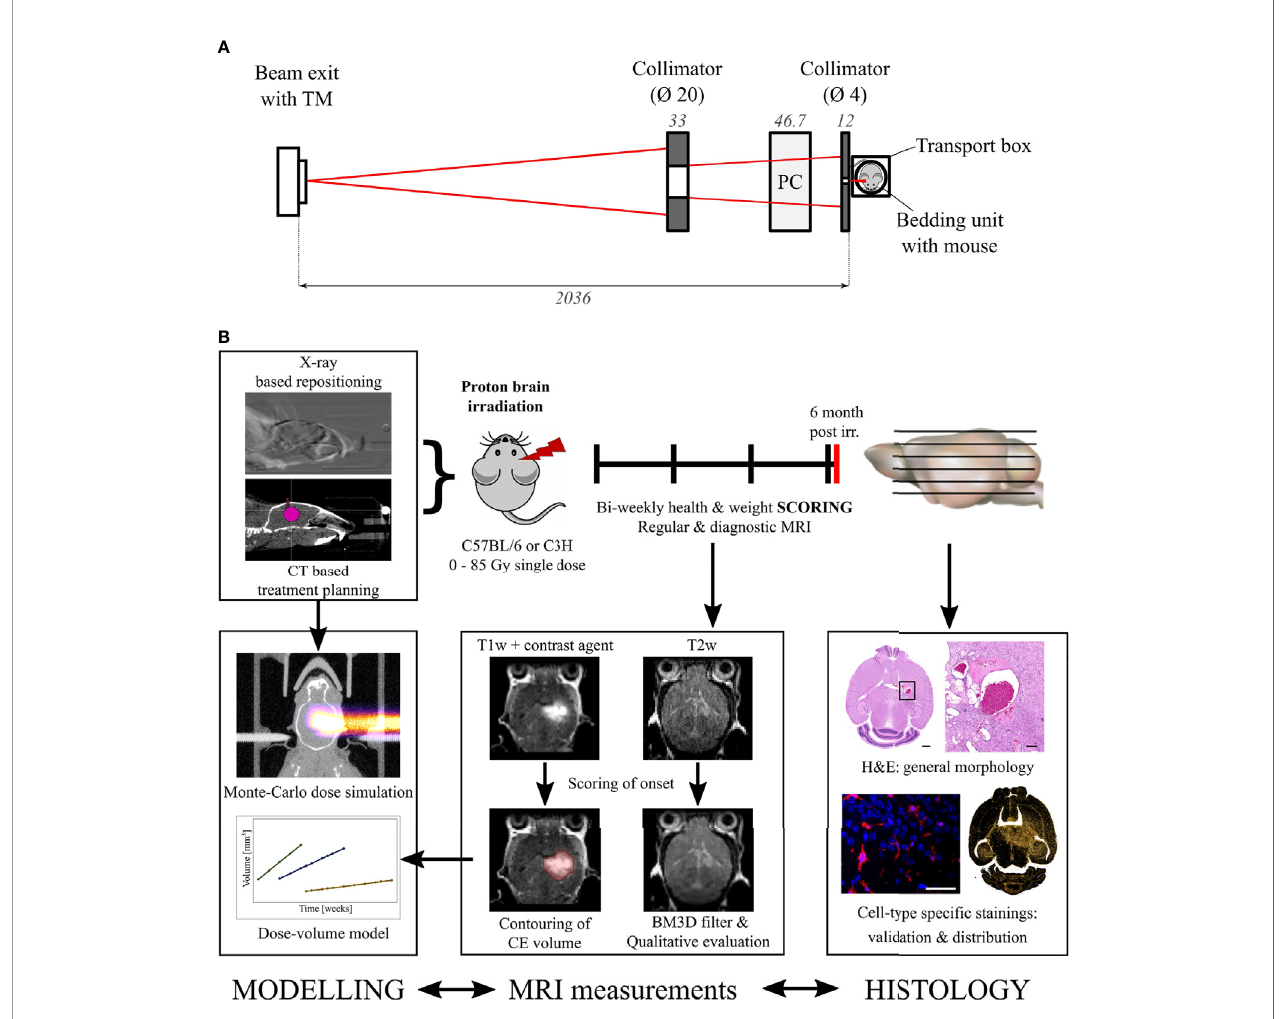
FIGURE 1 | Irradiation setup and experimental procedure. (A) Schematic representation of the beam shaping system. Left to right: A 90 MeV proton beam (red) exits the vacuum beam line and passes through a transmission monitor ionization chamber (TM). A brass (left) and an aluminum collimator (right) shape the beam which is range adjusted by a polycarbonate (PC) compensator before irradiating the mouse within the transportation box. Dimensions in mm. (B) Overview of the work fl ow and the speci fi ed endpoints. Modelling, MRI measurements, and histology are correlated to fi nd the dose evoking clinically comparable normal tissue